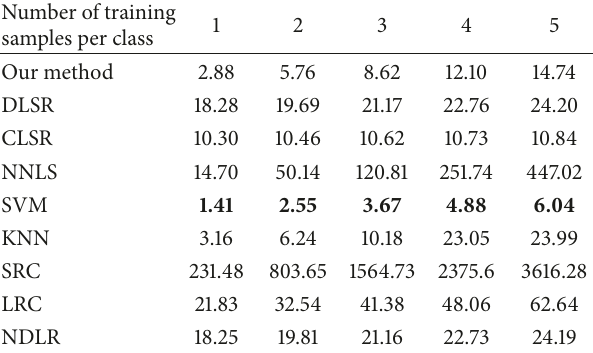
Table 8: Computing time (s) of different methods on the AR